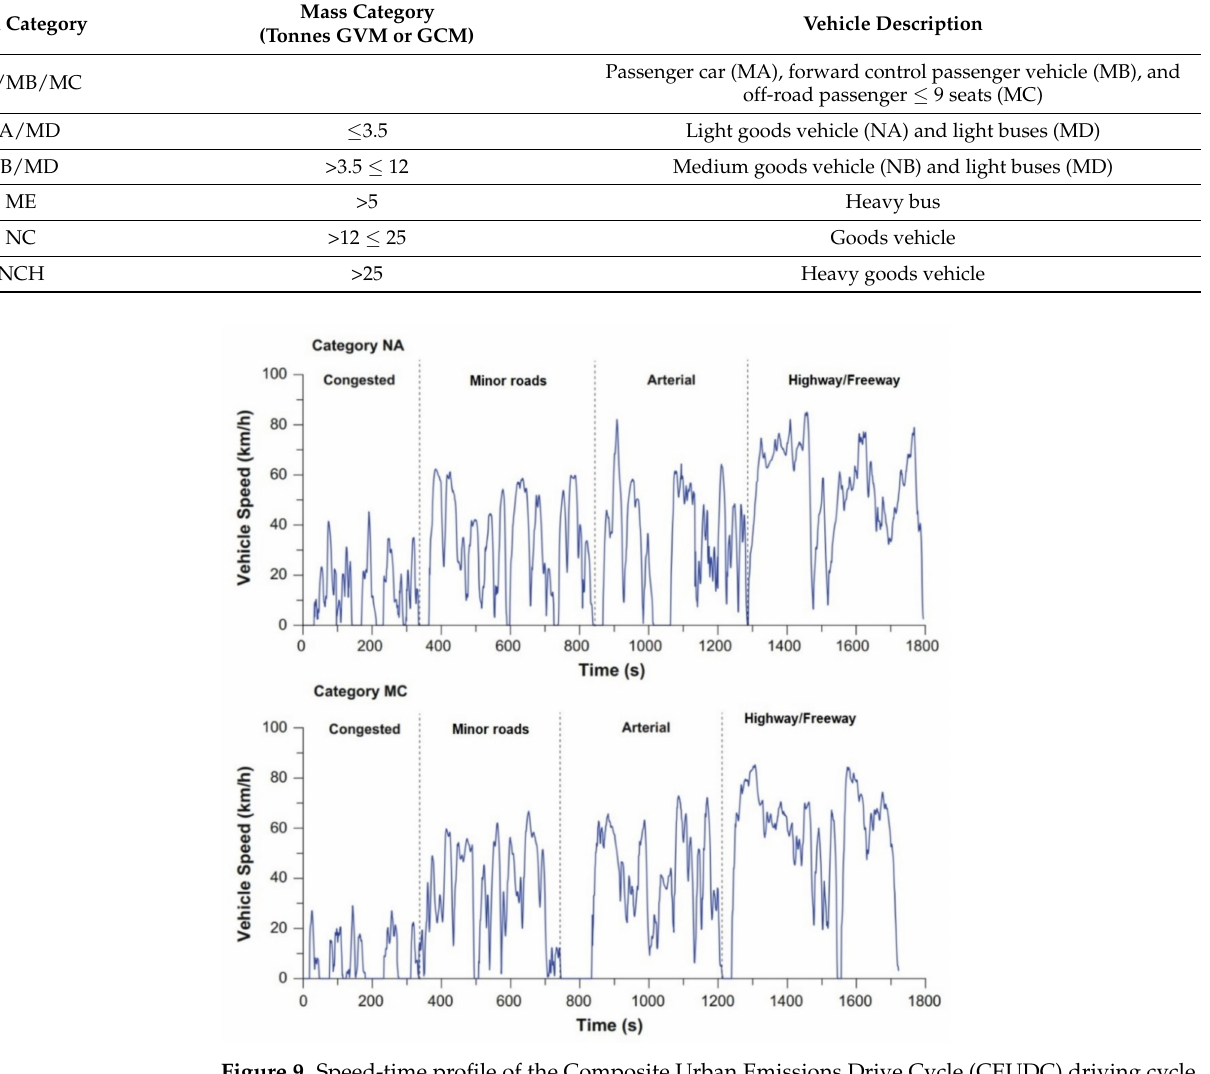
Figure 9. Speed-time profile of the Composite Urban Emissions Drive Cycle (CEUDC) driving